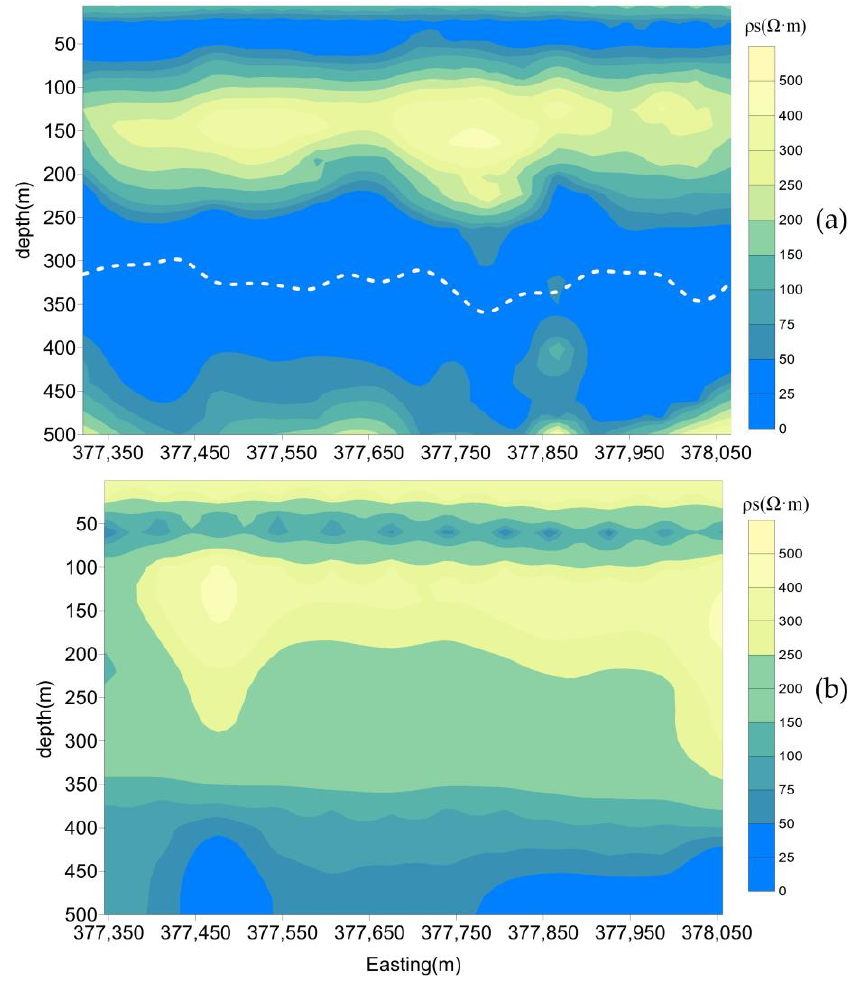
Figure 13. Comparison of inversion resistivity depth diagram between ( a ) iFTEM-I and ( b ) TEM-30B. The white dash line is the max depth of investigation according to Formula (2) and the peak-to-peak noise level (13 nT/s) in ( a ), not drawn in ( b ) because the maximum depth is deeper, and most are out of range.